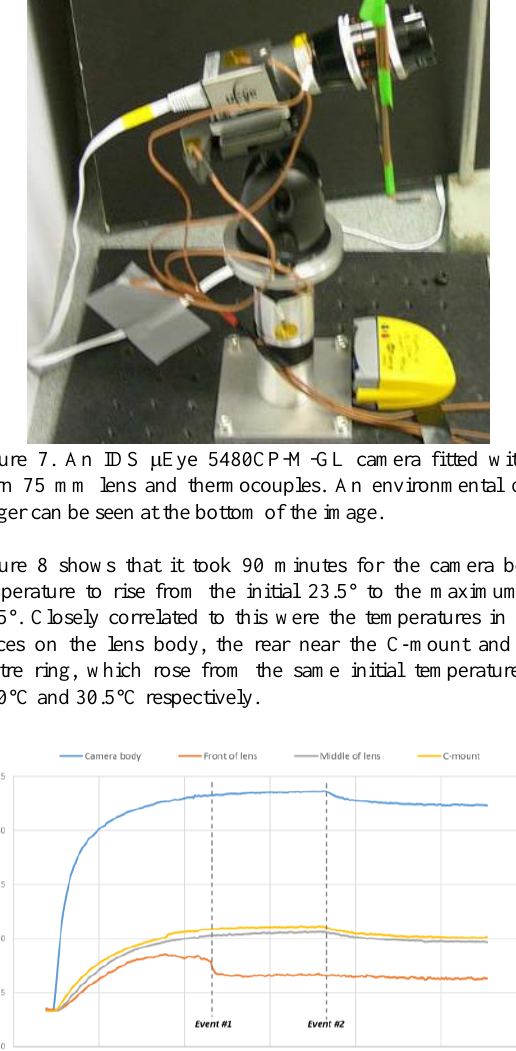
Figure 8. Temperature vs time of four thermocouples on camera and lens body.